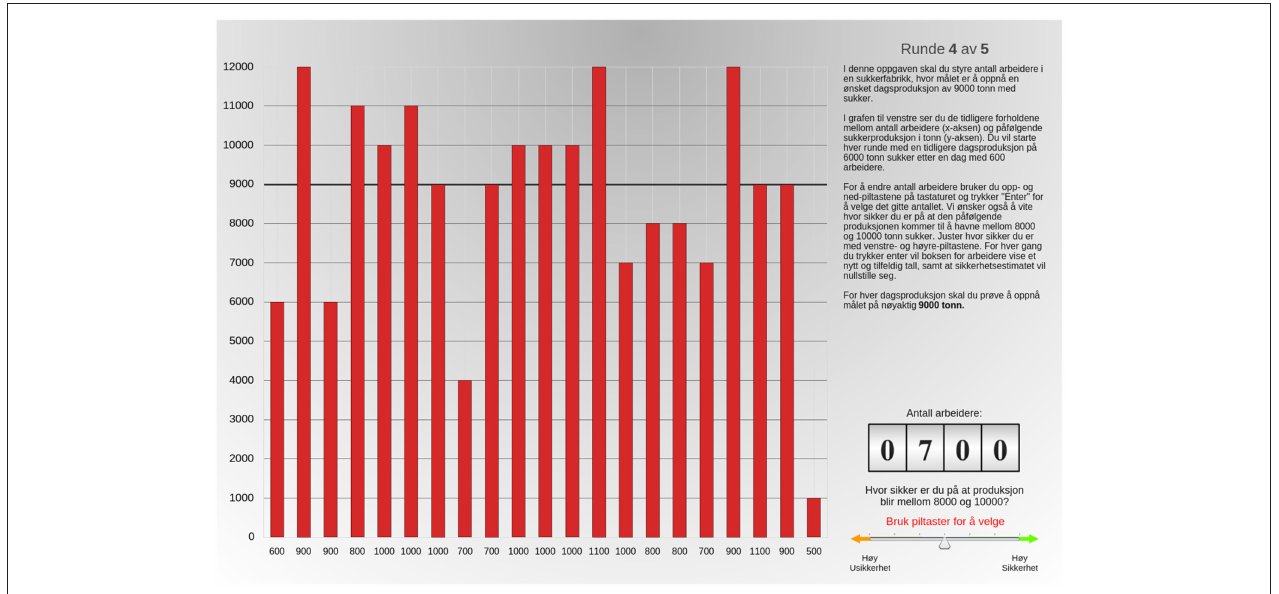
FIGURE 1 | A screenshot of the sugar factory task. The block has here been finished.